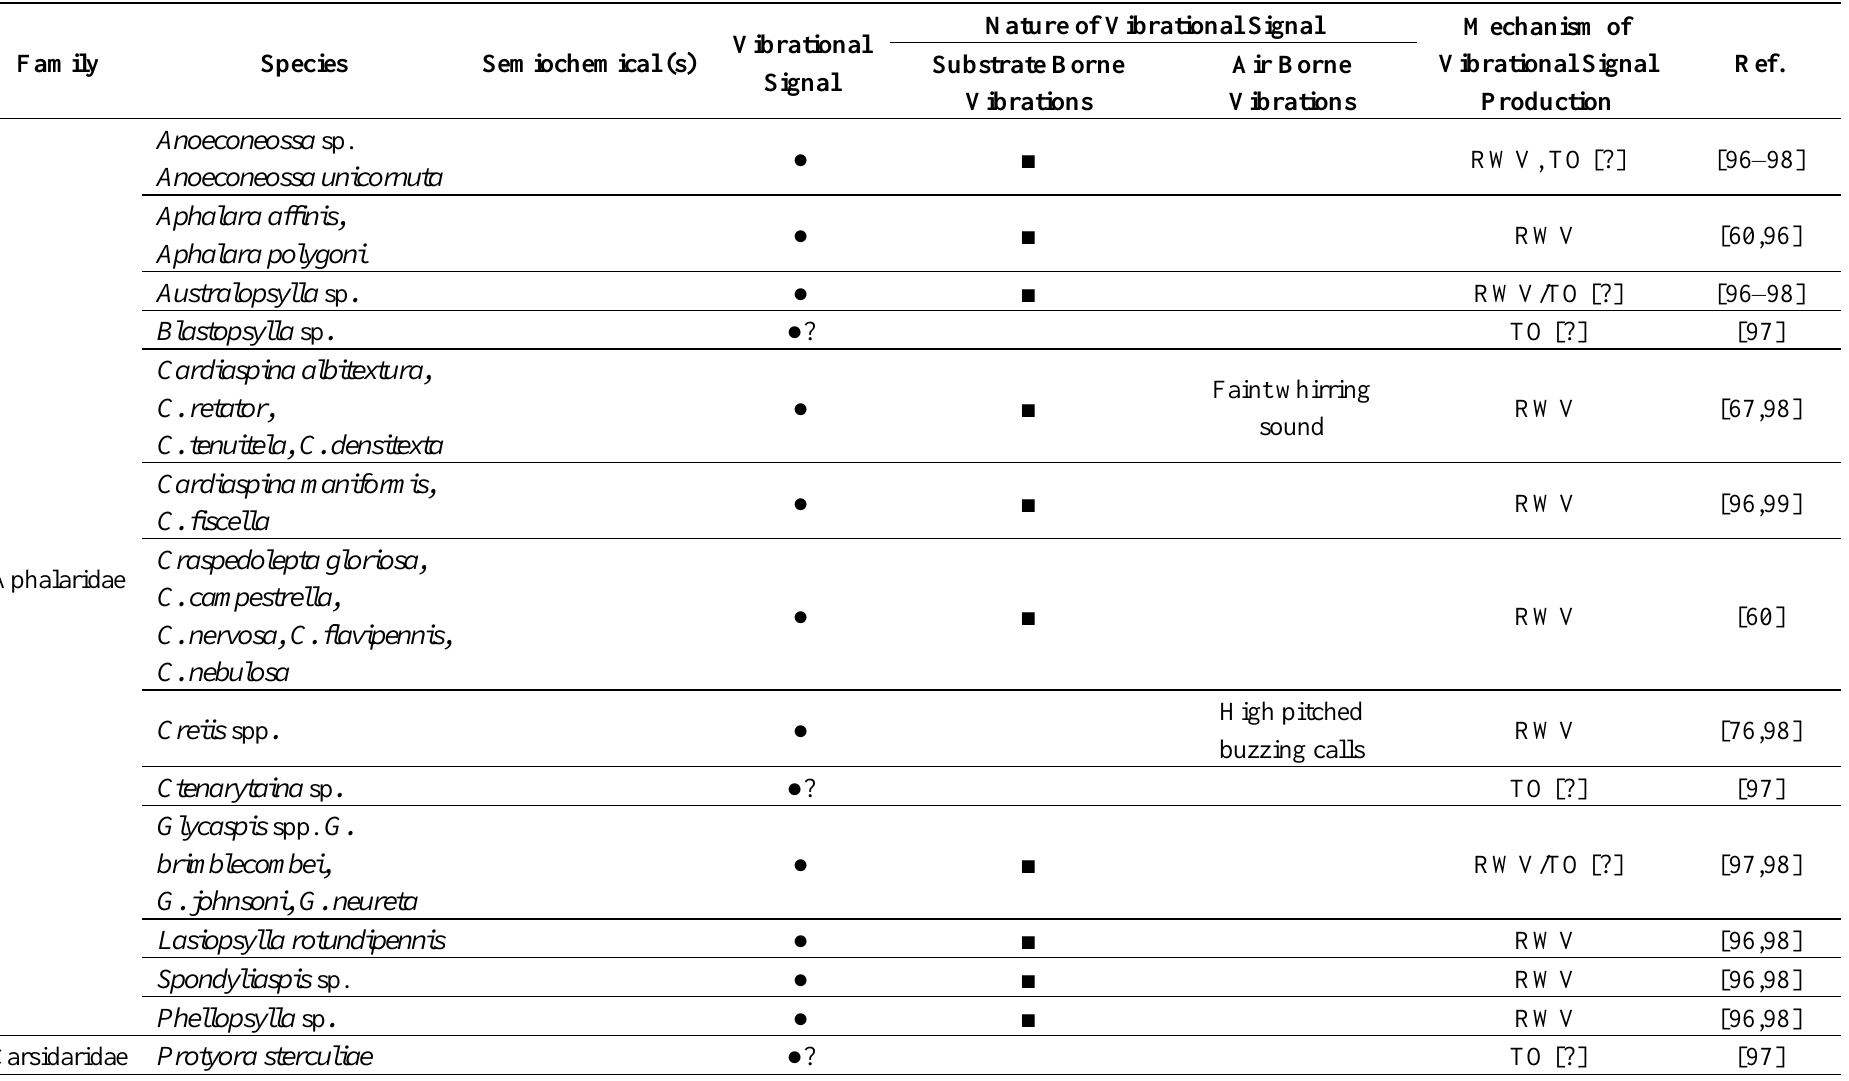
Table 1. Summary of signals mediating mate finding and courtship in